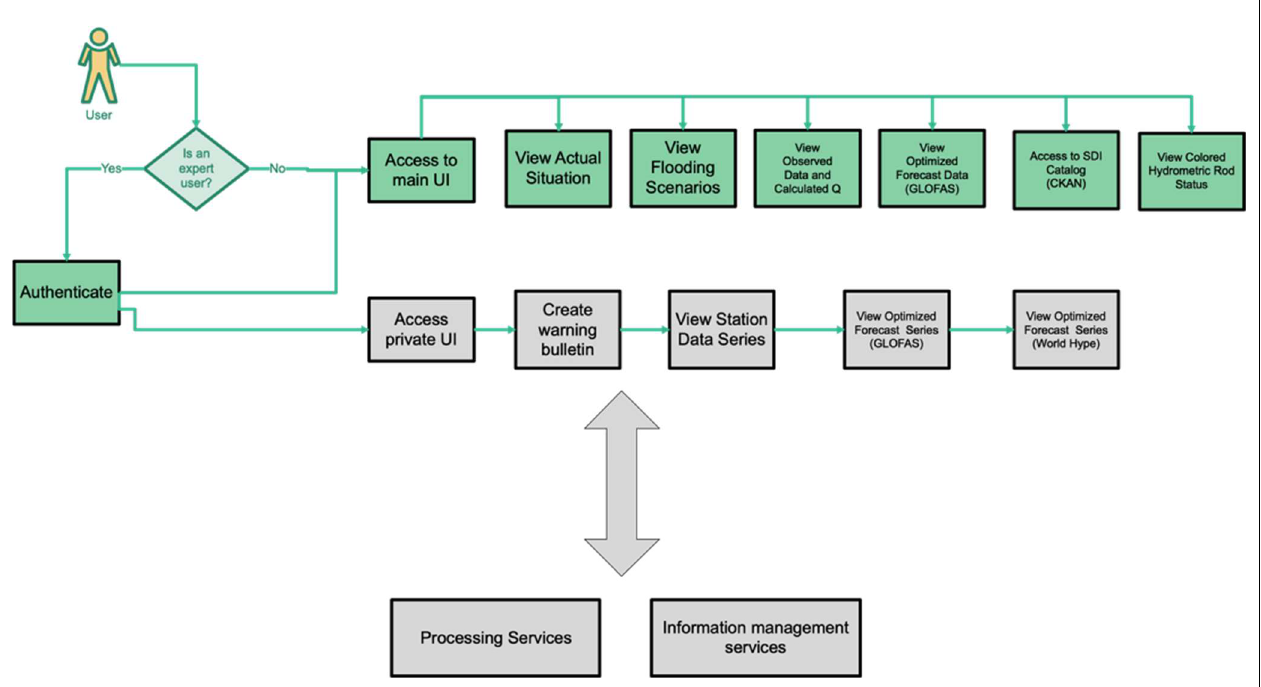
Figure 5. SLAPIS user functional diagram: WebApp layer.